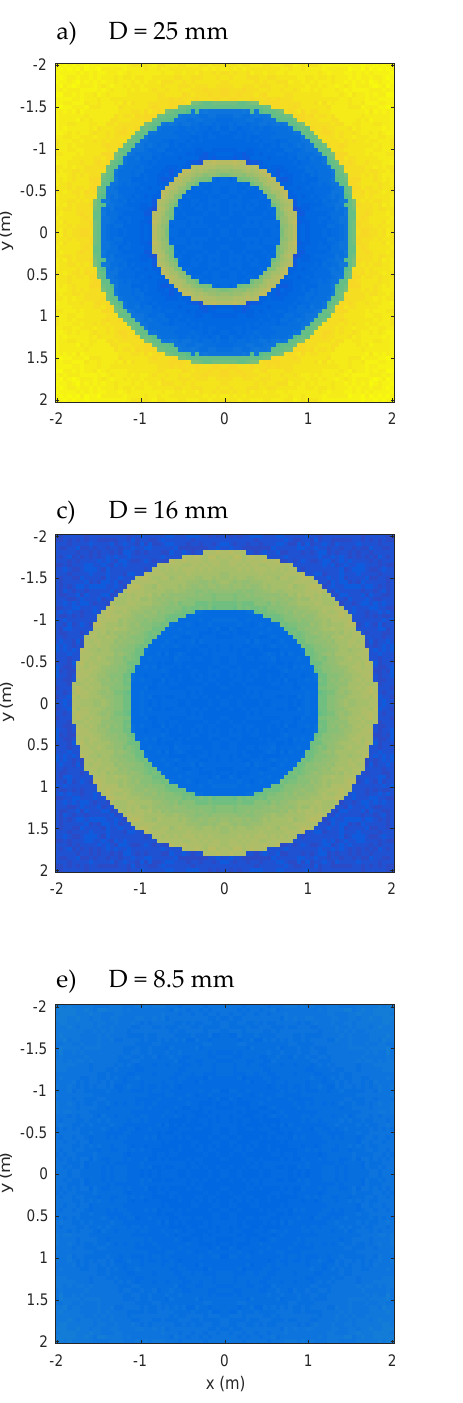
Figure 7. Computed range error at different transducer apertures D = {25, 20, 16, 13.1, 8.5, 6} mm in a dense grid of points (horizontal and vertical step = 0.05 m) belonging to the horizontal 4 m × 4 m Section B (see Figure 1); it is possible to appreciate the progressive widening of the disk of the minimum ranging error going from D = 25 mm to D = 6 mm. For aperture values D = 8.5 mm and D = 6 mm, the low error region includes all the half-space in front of the transducer.